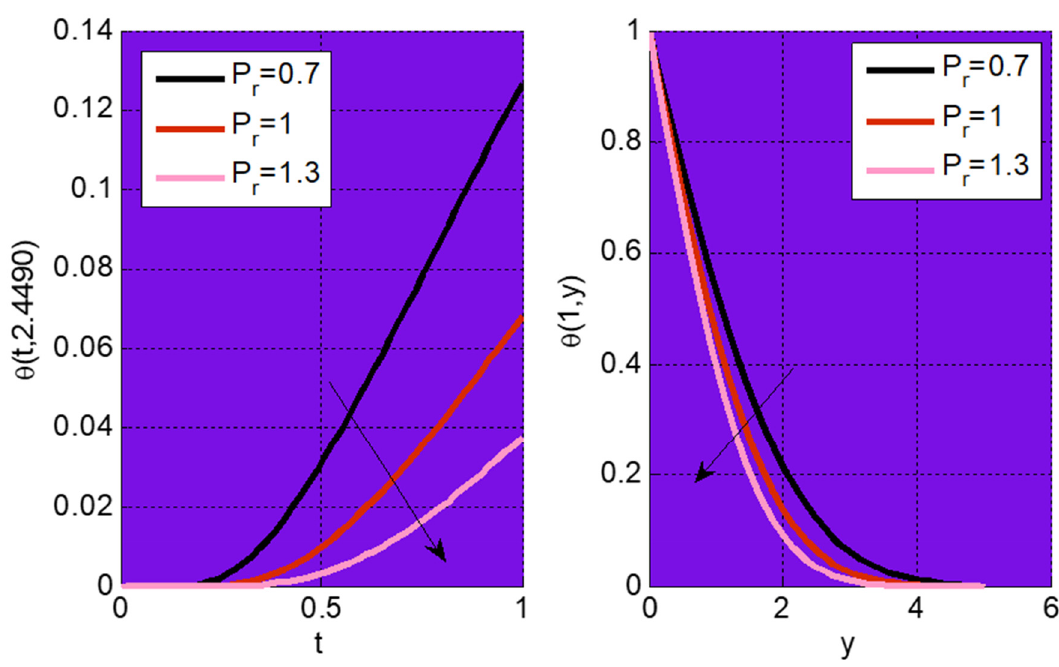
Figure 9. Impact of Prandtl number P r on the temperature profile of heat transfer for Stokes’ first problem in Quantum Calculus by the proposed scheme for spatial direction and Crank–Nicolson scheme for time direction using q = 0.8, N y = 50, N t = 50, β = 0.1, λ = 0.1, t f =